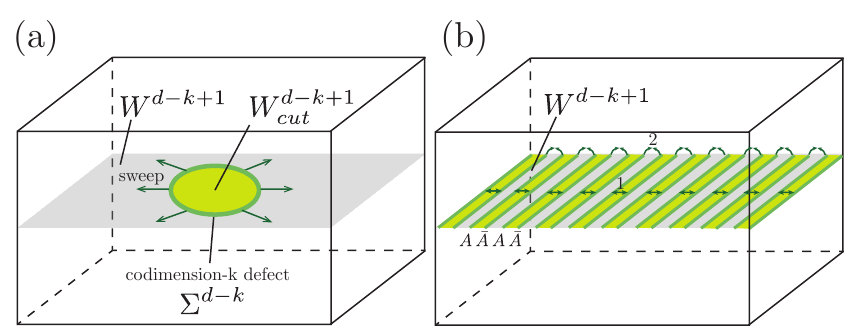
Figure 4: (a) Sweeping the codimension- k defect on a codimension- ( k − 1 ) subman- ifold (grey sheet) W d − k + 1 gives rise to an emergent ( k − 1 ) -form symmetry. The swept region is an open manifold W d − k + 1 (light green), while the codimension- k de- cut fect (green) is located on its boundary Σ d − k = ∂ W d − k + 1 . (b) For an invertible defect, cut the corresponding ( k − 1 ) -form symmetry operator is a constant-depth local quantum circuit, since the sweeping of the codimension- k invertible defect A can be done in two steps in O ( 1 ) time: (1) Parallel creation of a defect A and its inverse ¯ A separated with O ( 1 ) distance. (2) Parallel annihilation of the defect A with its neighboring in- verse ¯ A on the other side. Note that the box in the figure represents a 3-torus with periodic boundary